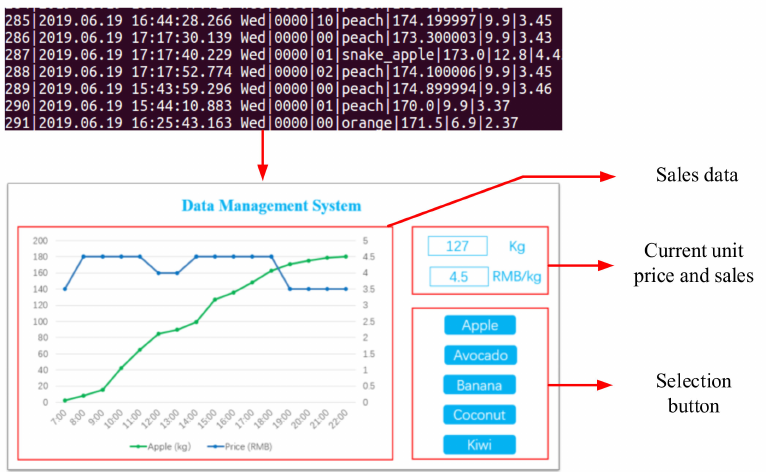
Figure 12. The terminal interface of the multi-device data management platform. By calling the cloud database data, the daily sales curve of different products can be visualized in the multi-device management platform, such as the inventory and sales price.